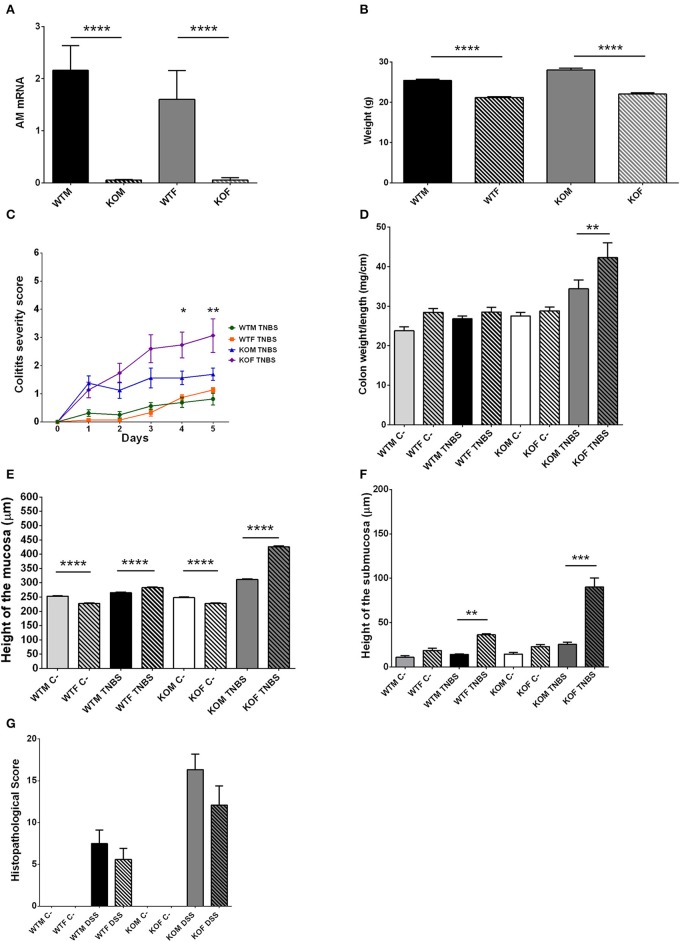
Sexual differences observed in TNBS-induced colitis. All results point to a higher degree of pathogenesis among female groups of both genotypes, being even more severe in KO females. To investigate the reasons for these differences, we first checked that abrogation of adm gene was completely achieved in both sexes (A). Another possibility was that the diverse susceptibilities may be due to differences in the weight of males versus females at the beginning of the experiment (B). TNBS treatment did not cause differences in clinical symptoms (C) or local inflammation (D) between WT males and females. However, lack of AM provokes a significant worsening (C) and more severe inflammation of the colon (D) in treated-KOF when compared with treated null-males. Morphometric studies of colonic sections revealed that in normal conditions (sham-groups) males had a thicker mucosa (E) than females, but no significant sexual differences could be observed in the submucosa layer (F). TNBS instillation reversed these conditions, thus treated females presented a thicker mucosa (E) and submucosa (F) than treated males. However, no sexual differences were observed when comparing the histological score obtained by treated males and treated females (G). (A–G) Data are shown as mean ± SEM. (A,B,D–G) One way ANOVA + Tukey's MCT. (C) Two way ANOVA + Tukey's MCT. *p < 0.05; **p < 0.01; ***p < 0.001; ****p < 0.0001. Same groups as in Figure 1.